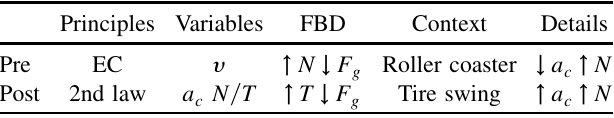
TABLE III. Comparison of pre and post problems. The FBD column refers to the relative orientations of acting forces in the free body